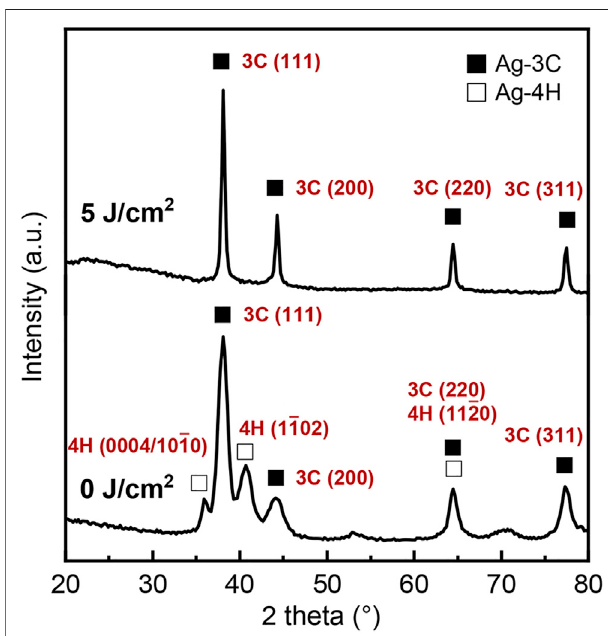
FIGURE 4 | XRD patterns of the donor fi lm (0 J/cm 2 ) and laser- transferred nanoparticles at 5 J/cm 2 .